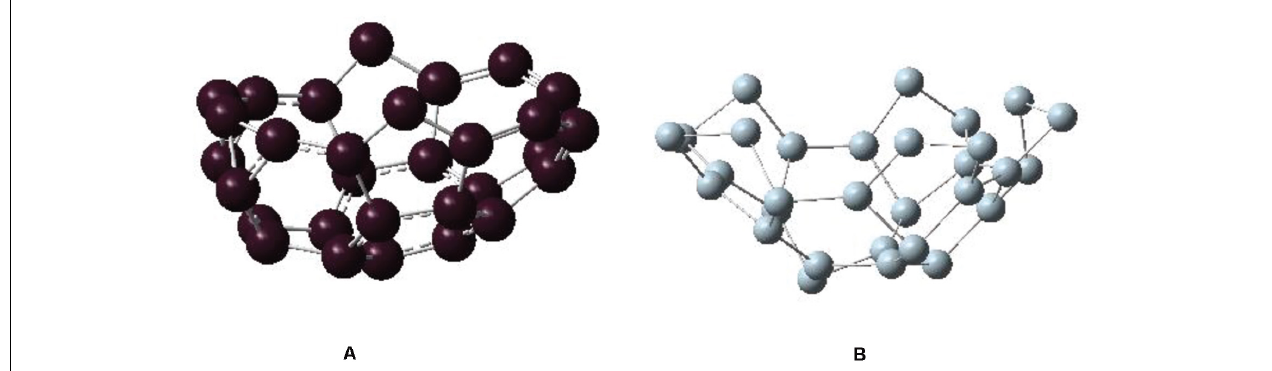
FIGURE 5 | Relaxed structures of (A) C 30 fullerene as bowl and (B) Si 30 fullerene as bowl.